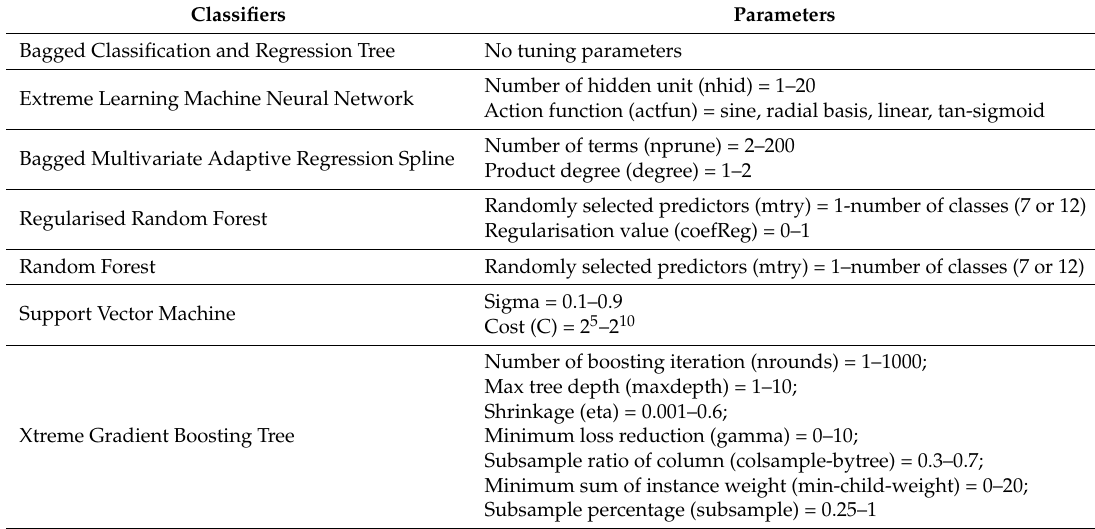
Figure 3. Pictures representing six types of the seven land-cover classes, including ( a ) forest, ( b ) rubber, ( c ) tea, ( d ) oil palm, ( e ) crop, and ( f ) built-up. Waterbody is sampled from Indian ocean. Table 2. Tuning parameters for each classifier.